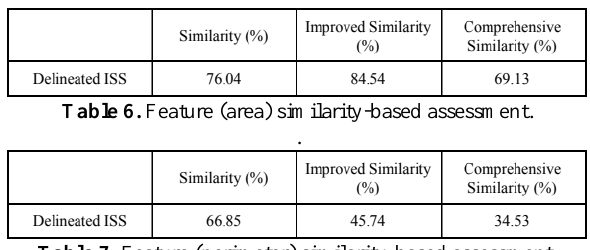
Table 7. Feature (perimeter) similarity-based